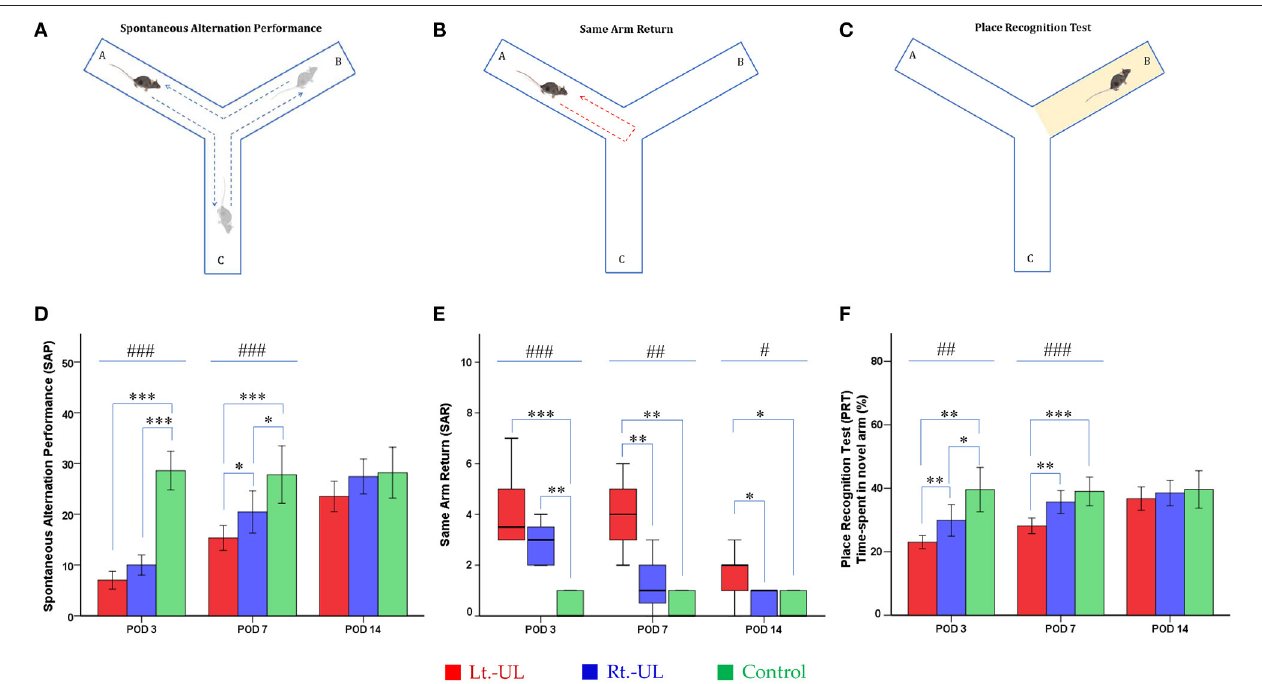
FIGURE 3 | Evaluation of locomotor activities and spatial navigation in the Y maze test. The spontaneous alternation performance (SAP) (A) of Lt.- and Rt.-UL groups decreased on POD 3 and 7 compared with the control group. The SAP values of the Lt.-UL group were significantly lower than those of the Rt.-UL group on POD 7. (D) The same arm return (SAR) (B) was significantly increased in both Lt.-UL and Rt.-UL groups on POD 3 compared with the control group. While the SAR value of the Rt.-UL group decreased to the level of the control group on POD 7, the SAR of the Lt.-UL group increased on POD 7 and 14 compared with the control group. The Lt.-UL group showed significantly increased SAR compared with the Rt.-UL group on POD 7 and 14 (E) . The place recognition test (PRT) (C) , an indicator of spatial reference memory, was significantly decreased in both Lt.-UL and Rt.-UL groups compared with the control group on POD 3 (F) . While the PRT value of the Rt.-UL group improved to the level of the control group on POD 7, the value of the Lt.-UL group remained lower than that of the control group on POD 7. The Lt.-UL group showed significantly reduced PRT values compared with the Rt.-UL on PODs 3 and 7 (F) . The values of SAP and PRT were indicated as mean ± SD, and the p -values were calculated using one-way ANOVA with post-hoc tests. The values of SAR were indicated as median (quartile range), and the p -values were calculated using the Kruskal–Wallis test and the Mann–Whitney U -test. *Significantly different between two groups; #significantly different between three groups; *, # p < 0.05; **, ## p < 0.01; ***, ### p <